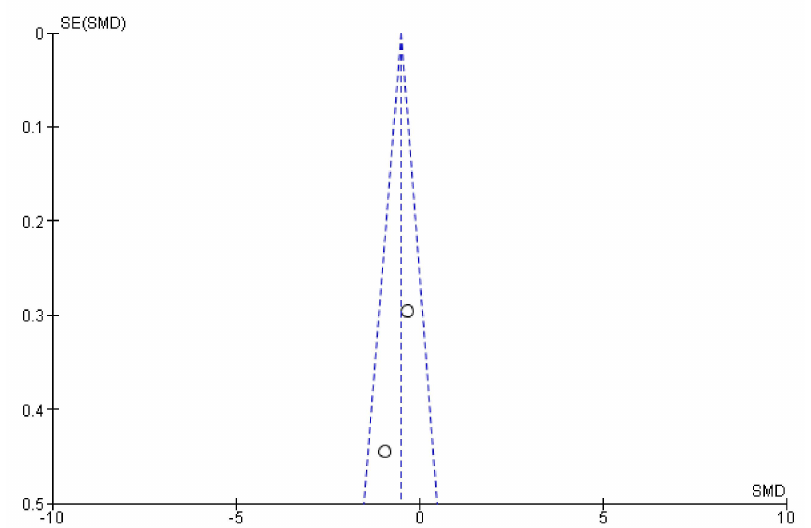
Figure 13. Funnel plot for dynamic balance